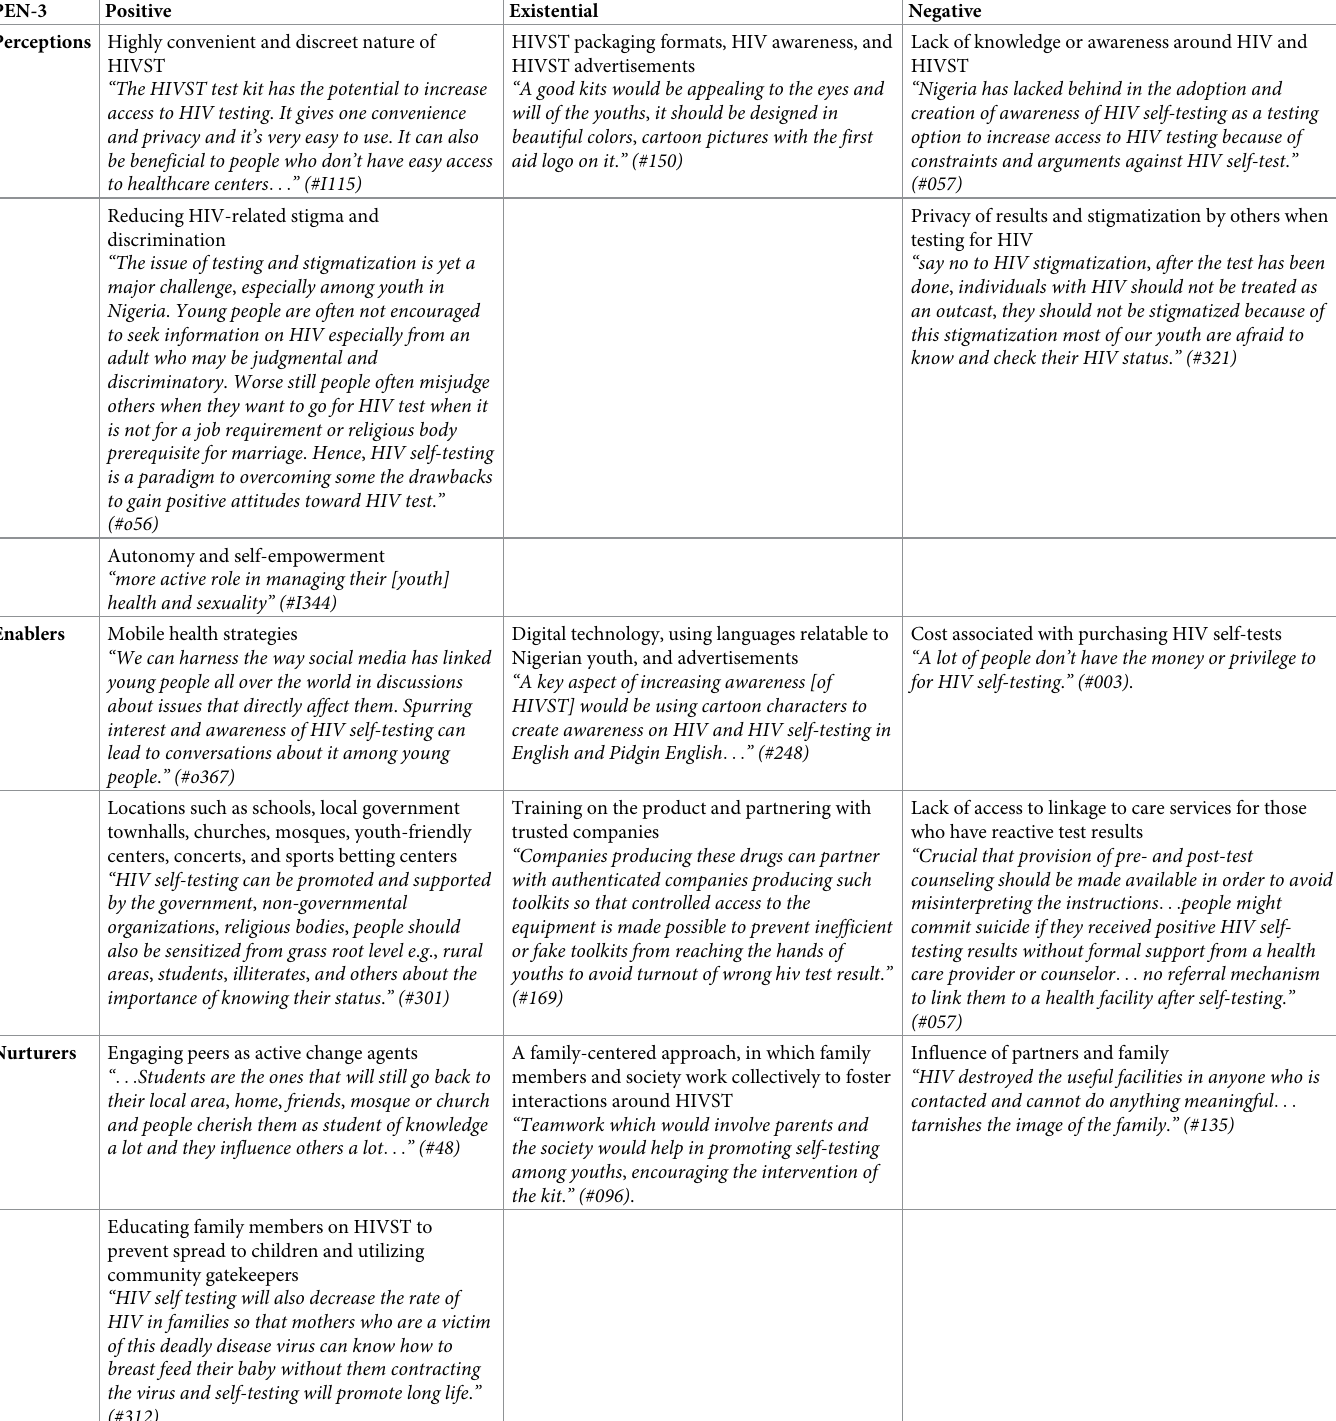
Table 2. Application of the PEN-3 � cultural